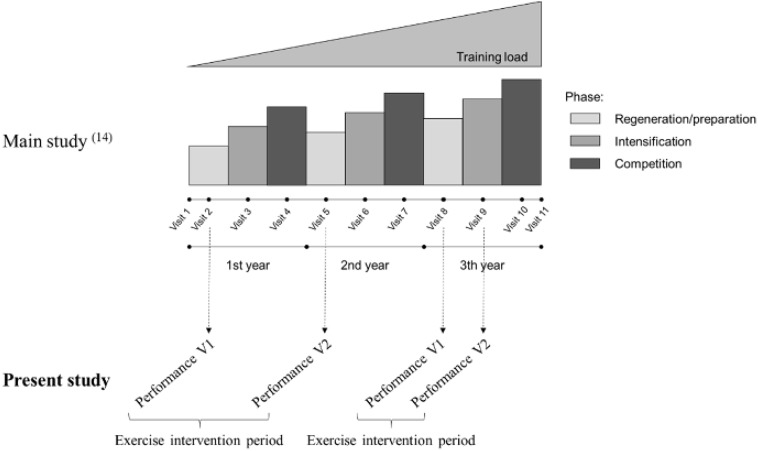
Study timeline (main and present study).